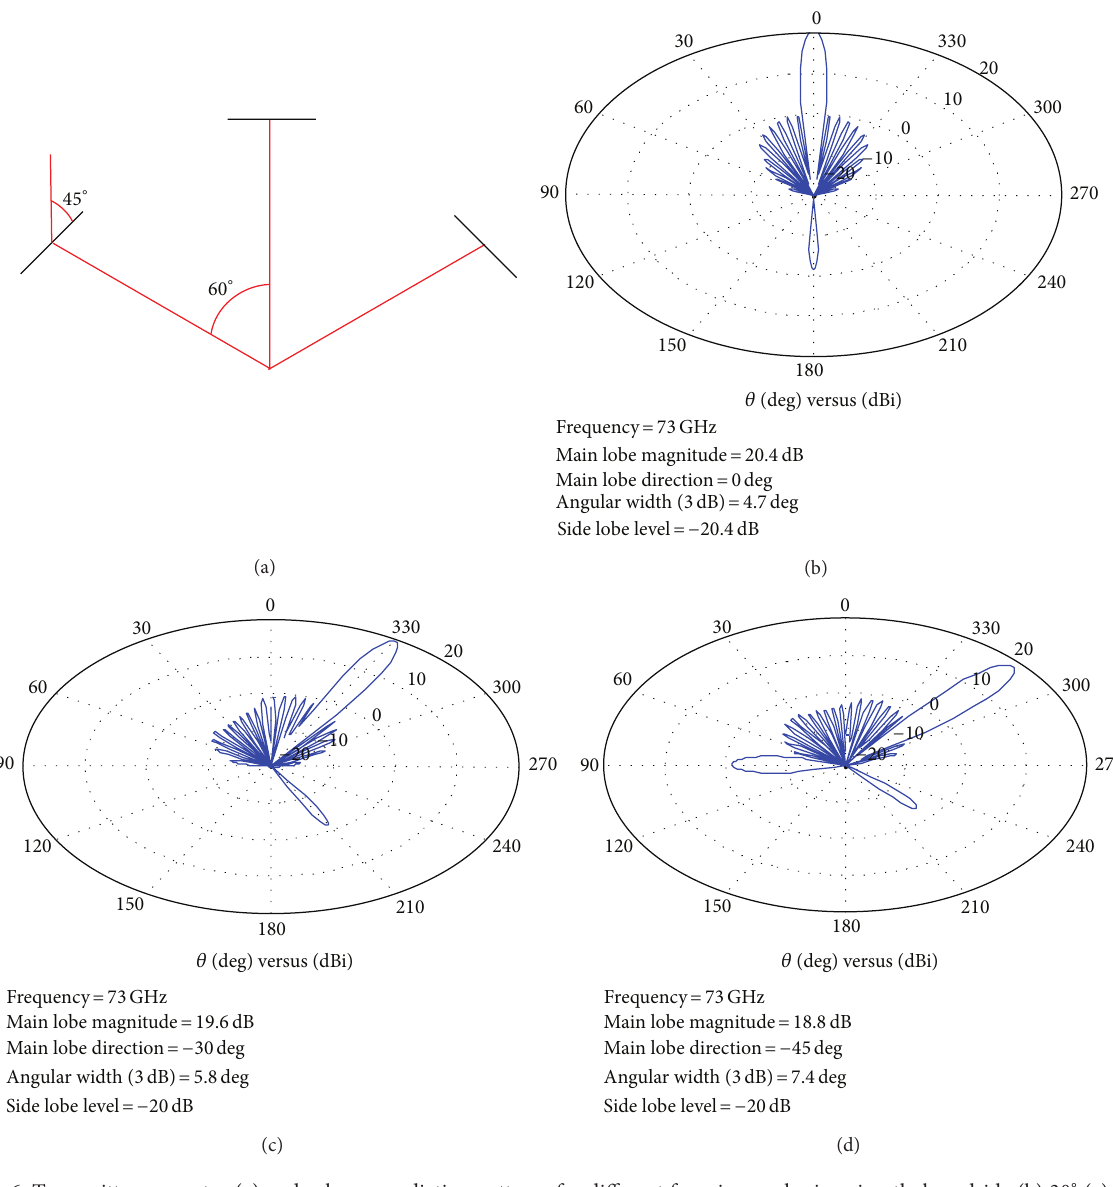
Figure 6: Transmitter geometry (a) and subarray radiation patterns for different focusing angles in azimuth: broadside (b) 30 ∘ (c) and 45 ∘